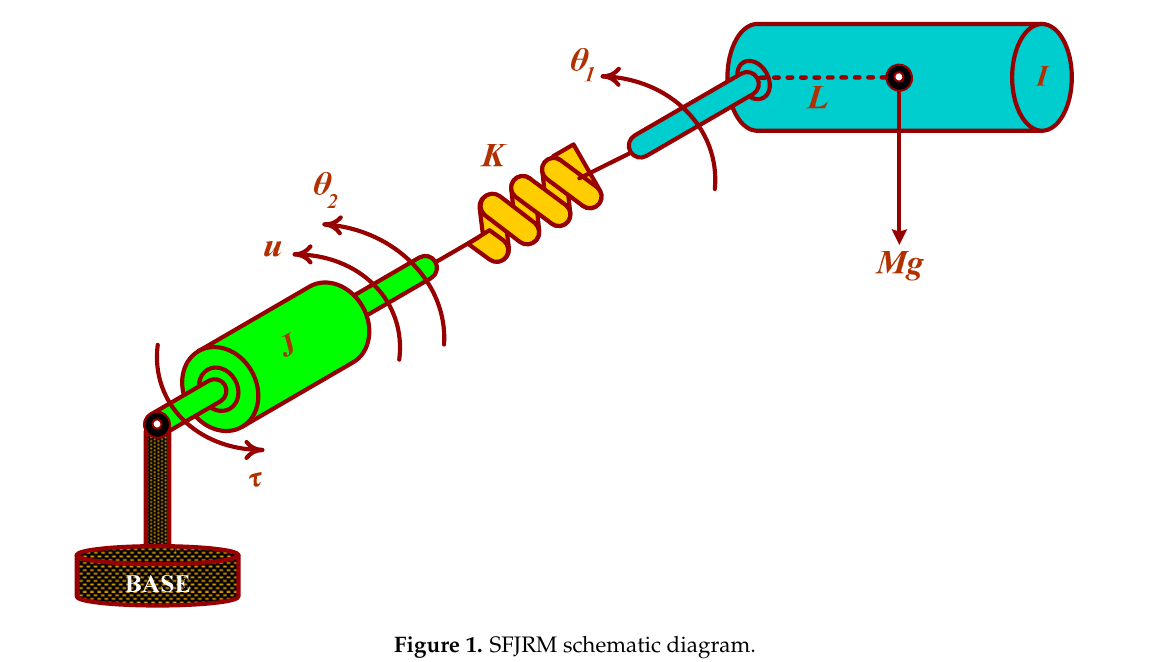
Figure 1. SFJRM schematic diagram.